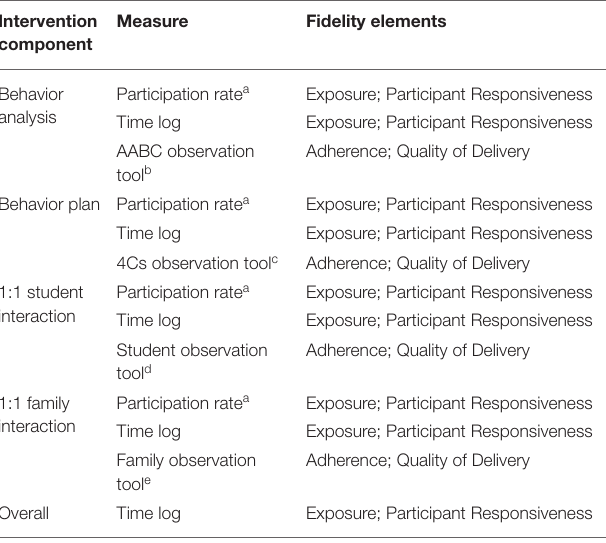
TABLE 2 | Intervention components with associated fidelity measures and elements. Intervention component